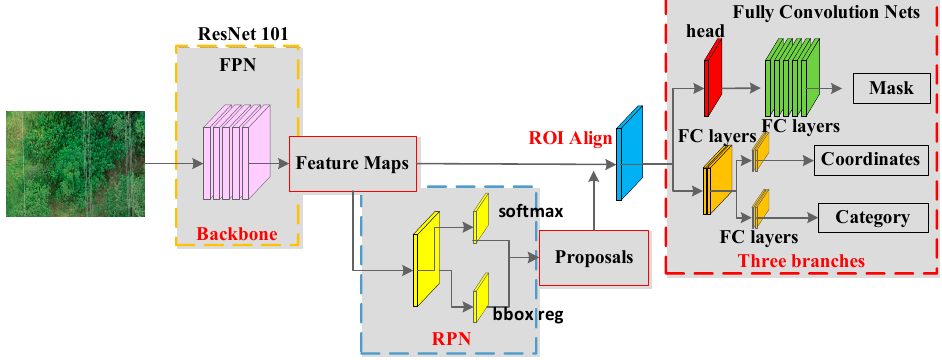
Figure 4. Mask RCNN network main structure diagram.